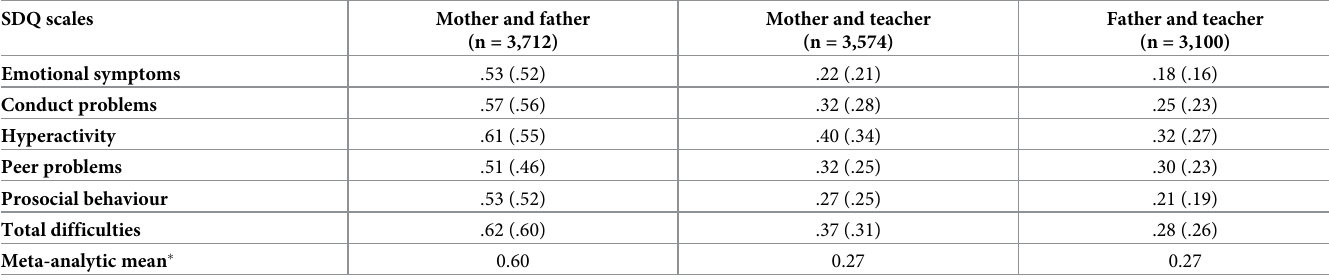
Table 4. Pearson inter-rater correlations for SDQ scores. SDQ